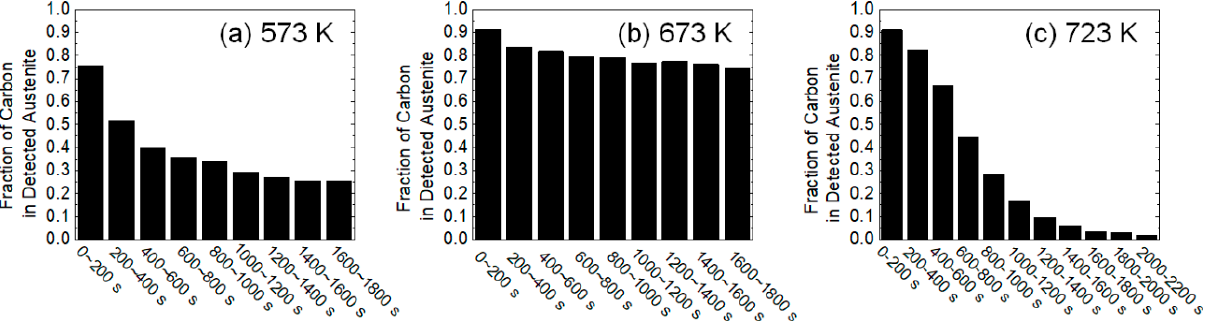
Figure 9. The fraction of carbon in detected austenite (FCDA) during the isothermal heating at ( a ) 573 K, ( b ) 673 K, and ( c ) 723